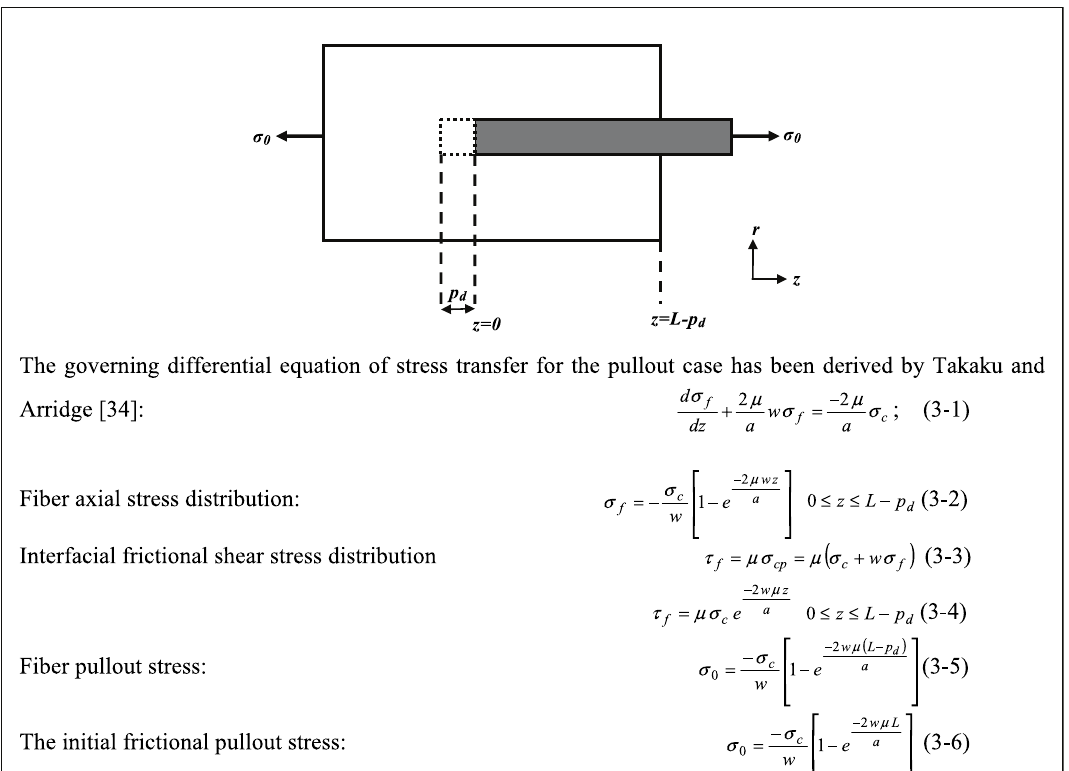
sional shear stresses at the interface. At the end of stage 1, debonding of the interface is initiated at the location where the fiber enters the matrix. Closed-form solutions are derived for the fiber axial stress distribution and the interfacial shear stress distribution along the fiber length, the fiber dis- placement, and the initial debonding stress ( i.e. , the fiber pullout stress required to initiate interfacial